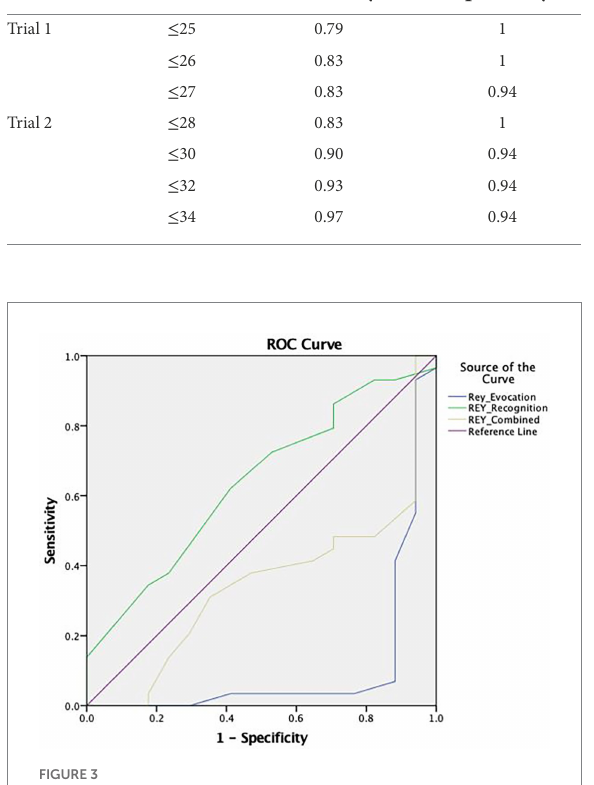
FIGURE 3 ROC curve concerning the discriminative capacity of the Rey 15-item Memory Test